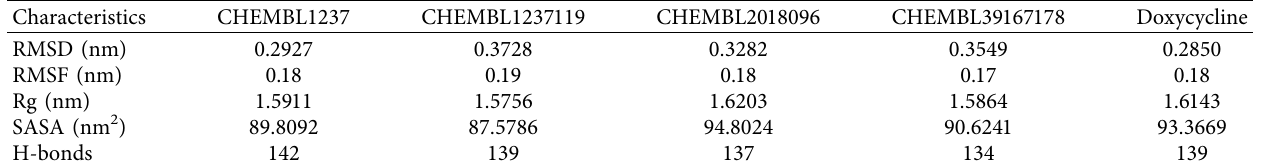
Table 4: Average values of simulated ligand-protein complexes at